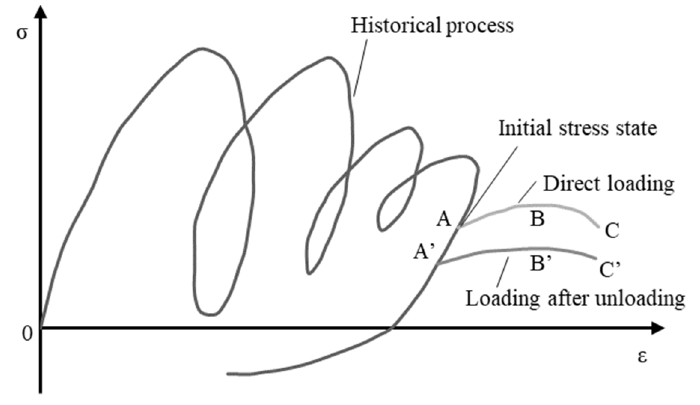
Figure 1. Stress-strain relationship under different loading conditions [12].